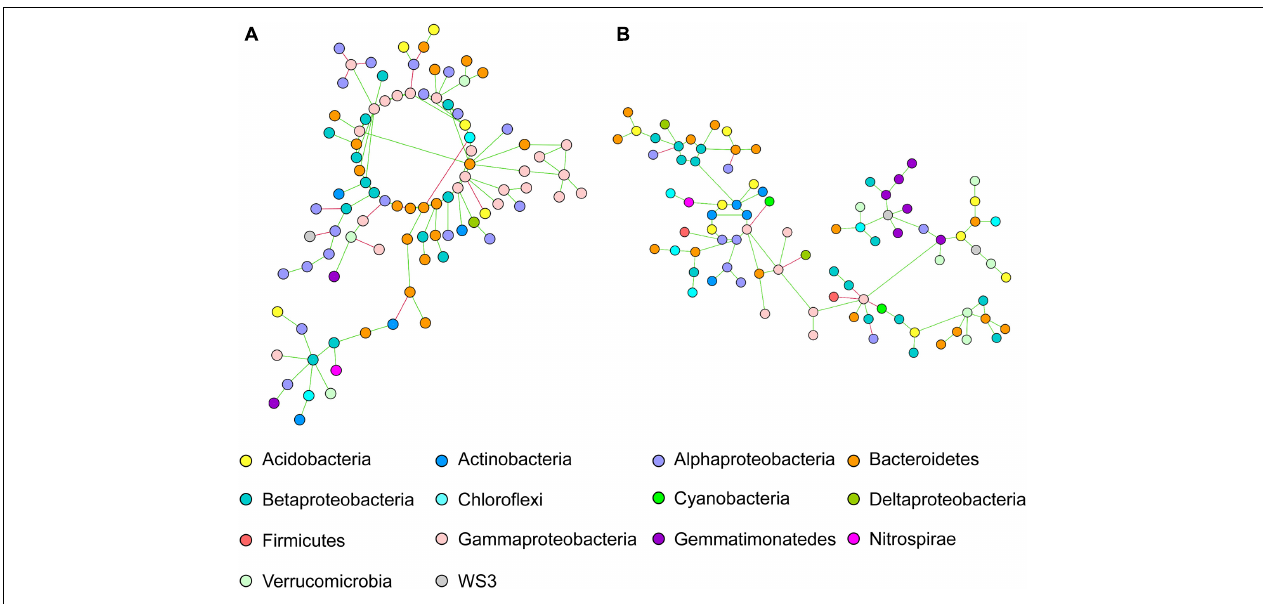
FIGURE 2 | Co-occurring bacterial network of OTUs belonging to intercropped (A) wheat and (B) pea rhizosphere network. Each network node (individual circle) represents an OTU. Network edges are represented as straight lines connecting the nodes and indicate significant co-occurrences based on partial correlation obtained from a Poisson Log Normal model ( r > | 0.06|, p < 0.05, n = 30 iterations); green for positives and red for negative